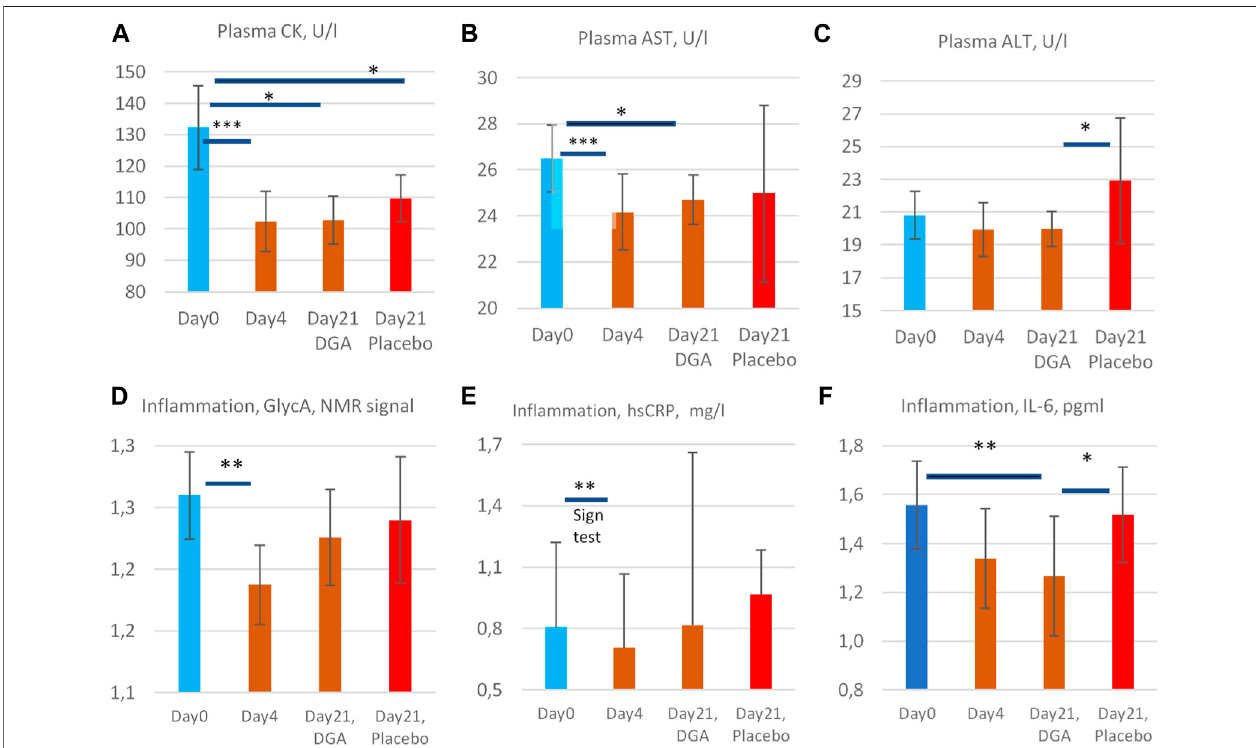
FIGURE 5 | Enzyme release of creatine kinase (A) , aspartate aminotransferase (B) , and alanine aminotransferase (C) into the plasma, and low-grade in fl ammation markers GlycA (D) , hsCRP ( E) , and IL-6 (F) . All statistical tests are based on intra-individual changes. SEM error bars are calculated from absolute values. Notes: 1) Day 21 bars in (A – F) are indexed to Day 0 bars so that the Day 21 results fully re fl ect the changes from the relevant DGA and placebo subgroups at Day 0. 2) There was one clear outlier in the 4-days result in CK and AST from the same participant (see Supplementary Presentation 1, Figures H,I ),and one outlier in IL-6 Day 0 results ( SupplementaryPresentation1,FigureP ).Additionally,inGlycA( Figure3D )thehighest1/3rankedbyVO 2 maxdeviatedclearlyfromtheotherparticipantsandfrom hsCRP(see SupplementaryPresentation1,FiguresN,O ).Theseobservationshavebeenexcludedtoachievenormalityofthedata.Importantly,evenincludingthese outliers, the respective changes in CK, AST, GlycA, and IL-6 would have been statistically signi fi cant. 3) The hsCRP data is non-normal due to very high volatility. Due to the high volatility median values of hsCRP are presented in (E) and a non-parametric Sign test was used for the 4-days change. 4) All other bars represent arithmetic means and the intraindividual changes for all others were normally disrtibuted. Statistically more powerful paired t -test was used when comparing the intraindividual changes from Day 0 in (A,B,D, and F) . 5) Naturally, when comparing the changes from Day 0 to Day 21 in the placebo group vs. the DGA group (ALT and IL-6, (C,F) ), a paired t -test could not be used. Instead, a non-paired t -test was used to compare the changes in the placebo vs. DGA for ALT and